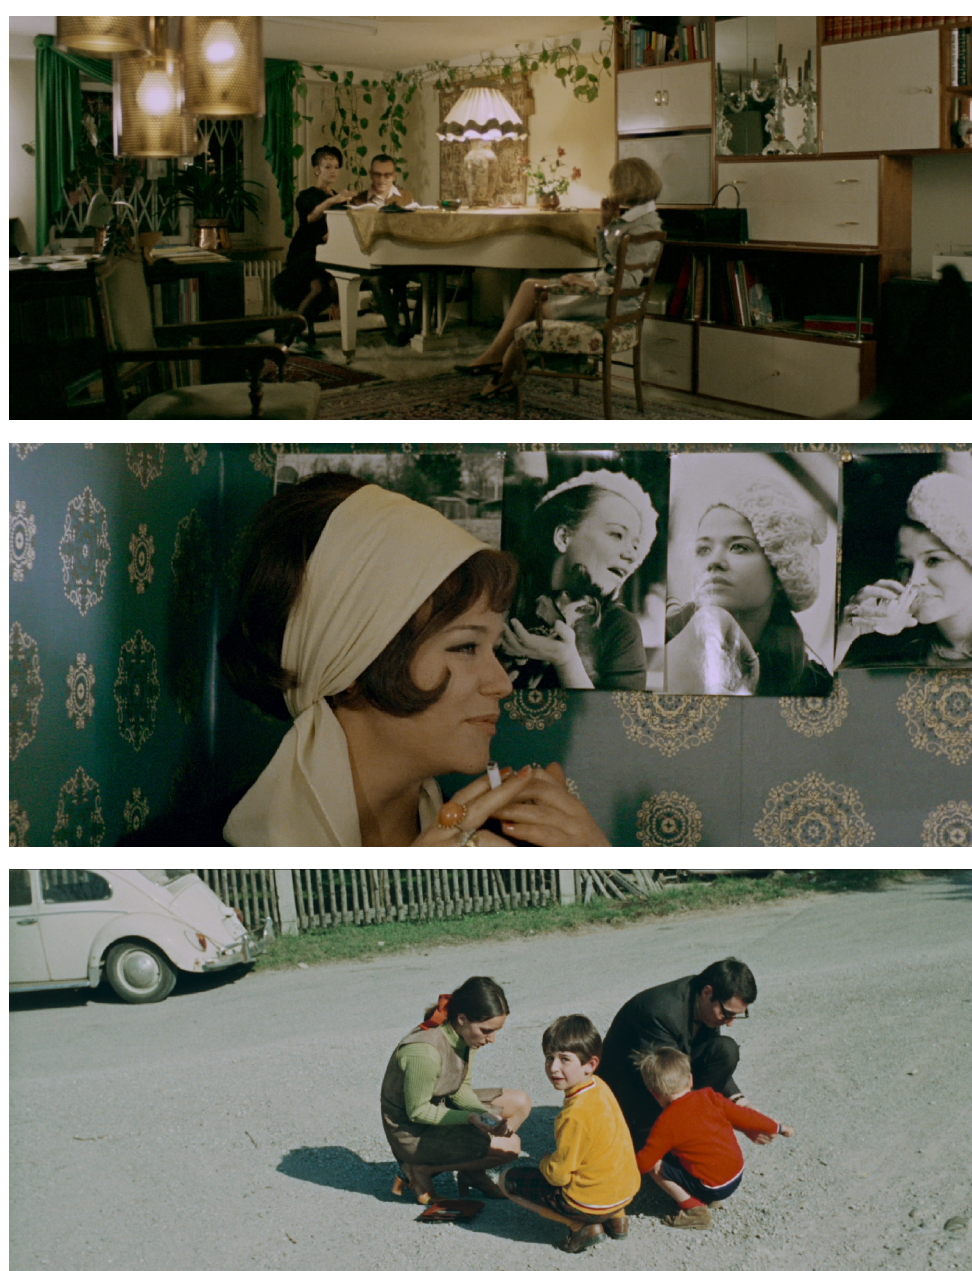
Figure 2: The Cat Has Nine Lives